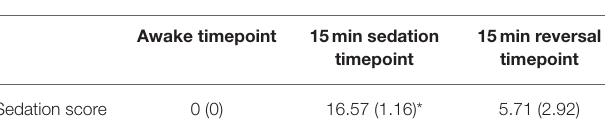
TABLE 2 | Sedation